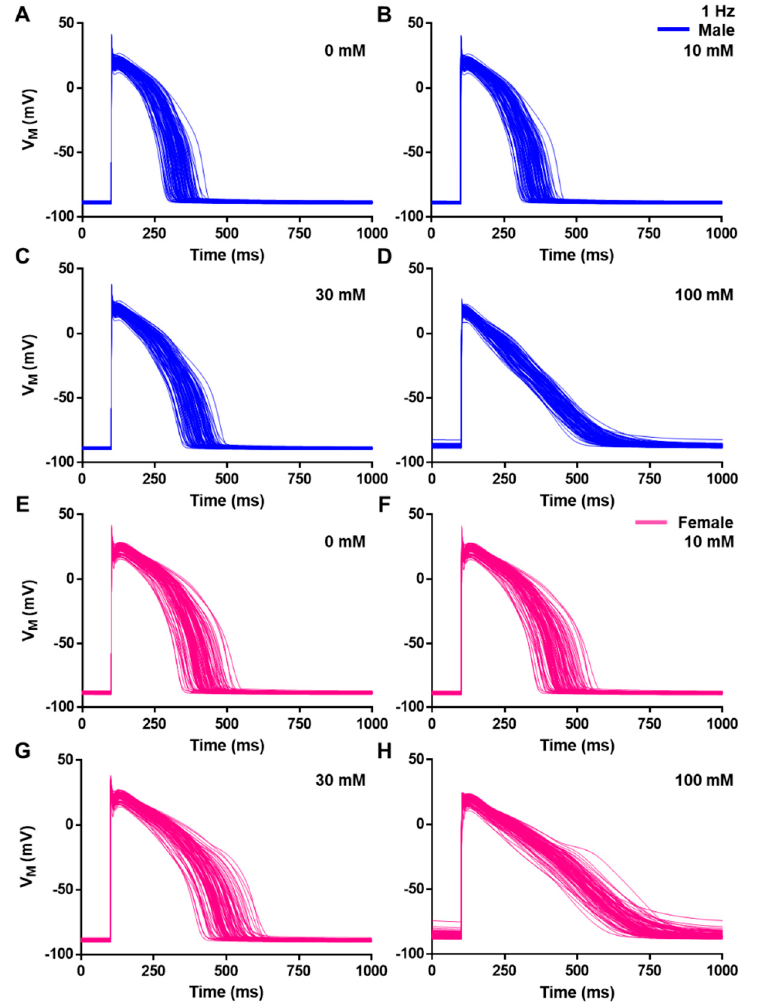
Figure 4. Populations of models depicting the effect of naringenin on ventricular action potentials. One thousand model variations of the ToR-ORd model were made by altering the maximum con- ductance of nine major cardiac ion channels to represent biological variations (e.g., intercellular variability) in ventricular cardiomyocytes. In this figure, ‘only’ 100 AP variations were shown to maintain visibility. Naringenin was administered in three different concentrations: 10 ( B , F ), 30 ( C , G ), and 100 µ M ( D , H ). Male = blue APs ( A–D ); Female = magenta APs ( E–H